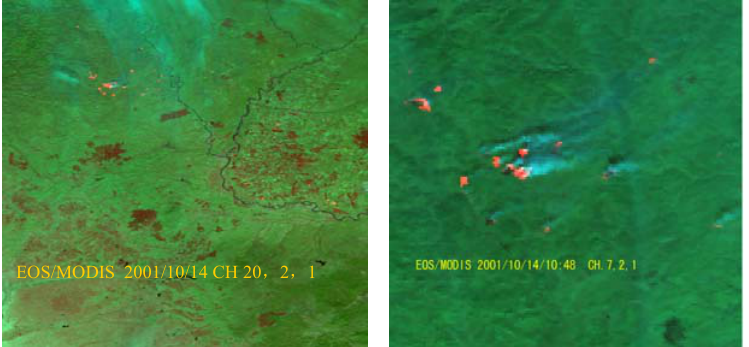
Figure 5. Forest fire hot spot detection using EOS/MODIS in Northern